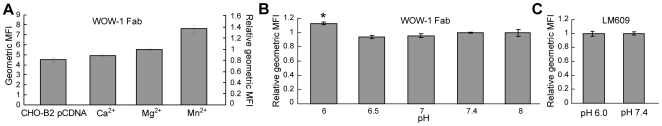
Flow cytometry measurements demonstrate increased level of activated αvβ3 on live cell surfaces after exposure to acidic extracellular pH.(A) WOW-1 Fab binding in the presence of various divalent cations. Data are displayed as the average geometric MFI of triplicate samples from a single representative experiment (primary axis), as well as the normalized geometric MFI (see Methods) expressed relative to the average value measured in the presence of Mg2+ ions (secondary axis), to enable direct comparison to (B). (B) WOW-1 Fab binding after exposure to pH 6.0–8.0. Data are normalized geometric MFI (see Methods) at each pH expressed relative to the average value measured at pH 7.4. Averaged data displayed here were calculated from at least two independent experiments at each pH. Asterisk indicates p<0.01 with respect to all other pH conditions. (C) LM609 binding after exposure to pH 6.0 or 7.4. Data is expressed as in (B). All error bars represent SEM.